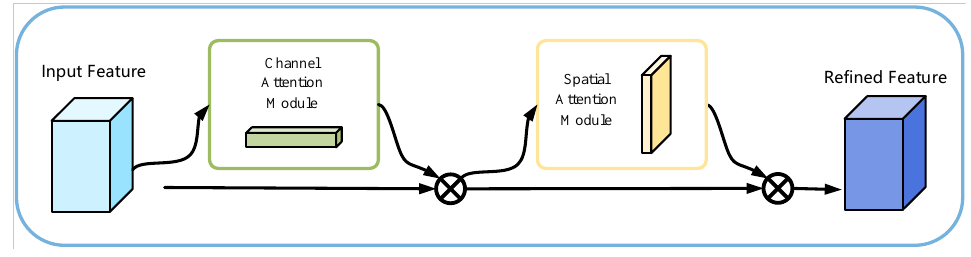
Figure 4. Illustration of the architecture of the attention